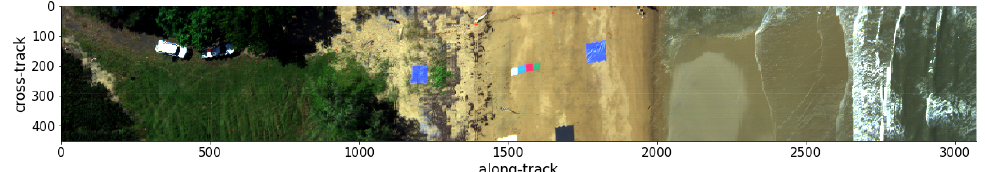
Figure 16. RGB visualisation of radiance using the 640, 550, 470 nm bands. Colours are scaled to the 2–98% percentile.